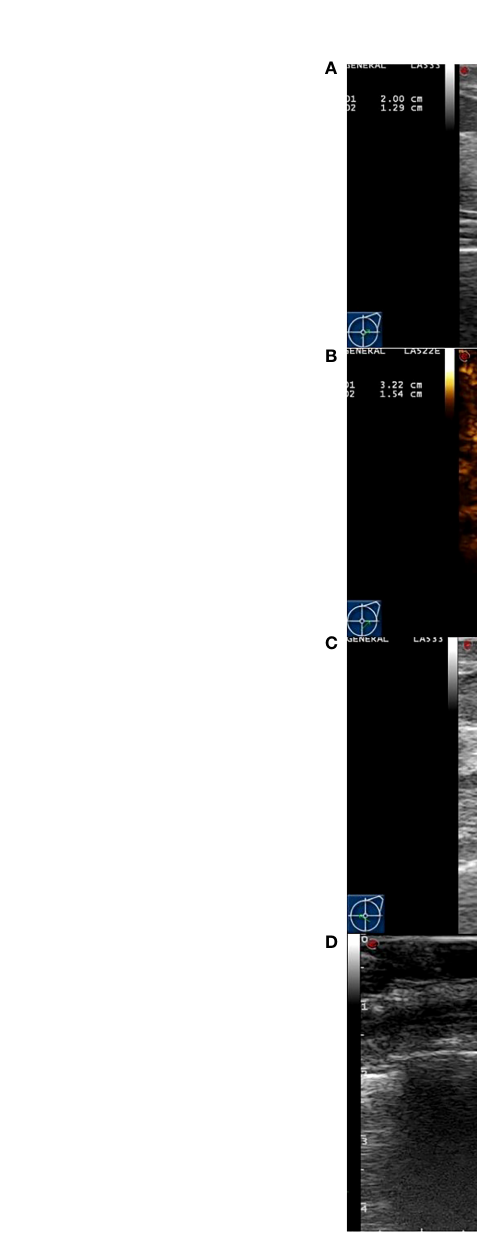
FIGURE 3 Images from a patient of response to NAC. (A) At baseline before NAC, the tumor size was measured by ultrasonography. (B) At baseline before NAC, the tumor size was measured by contrast-enhanced ultrasound. The extent of tumor was signi fi cantly larger than that of ultrasonography. (C) After the last cycle of NAC before surgery, the tumor has disappeared fundamentally by ultrasonography. (D) After the last cycle of NAC before surgery, there was not area of high enhancement